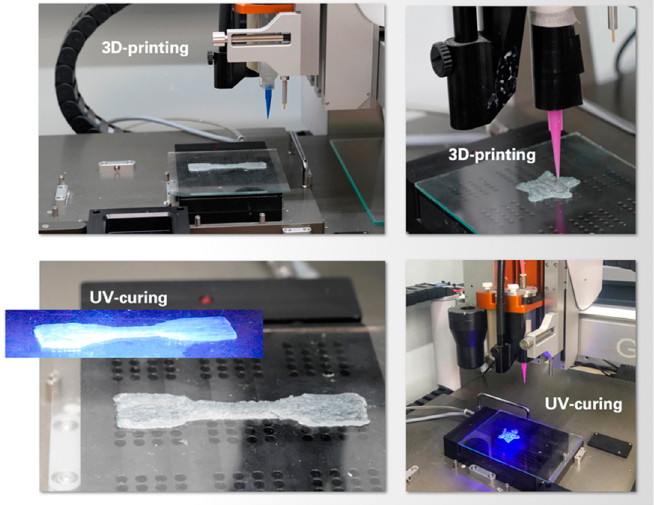
Figure 3. Examples of 3D-printed structures prepared using compositions based on AA/ChCl (dog- bone-shaped) and AA/ImCl (star). (dog-bone-shaped) and AA/ImCl